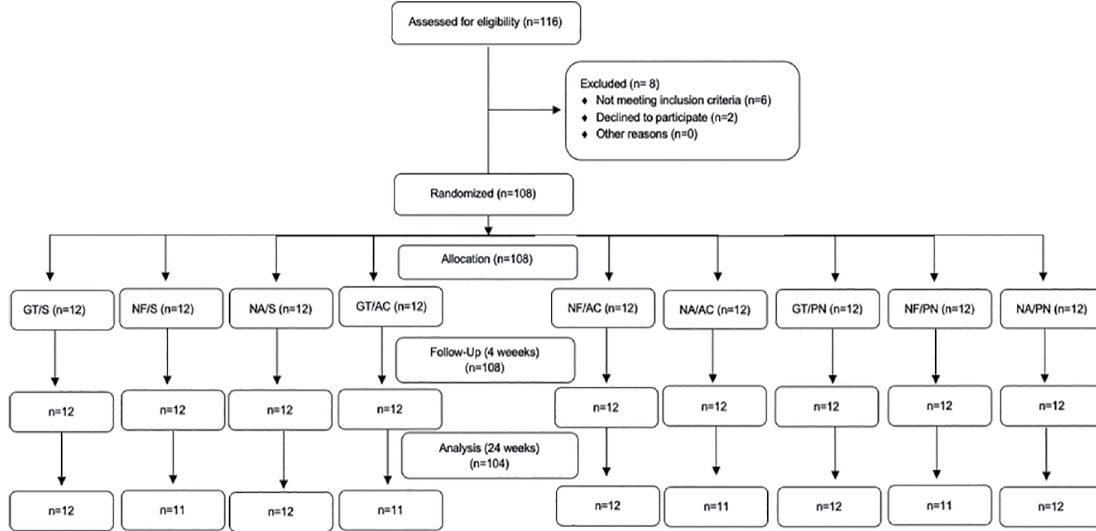
Figure 4- CONSORT flow